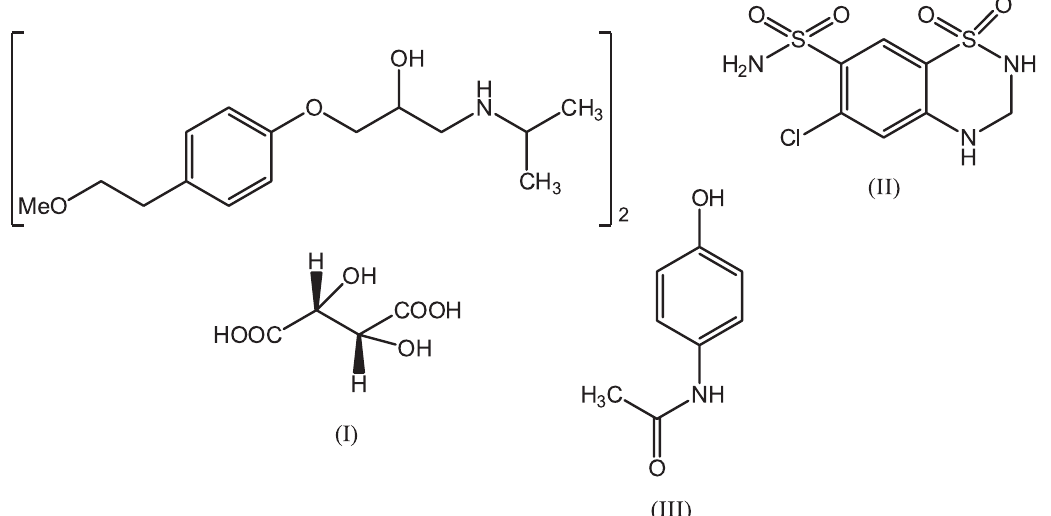
FIGURA 1 - Structure of metoprolol tartarate (I), hydrochlorothiazide (II) and paracetamol (IS)